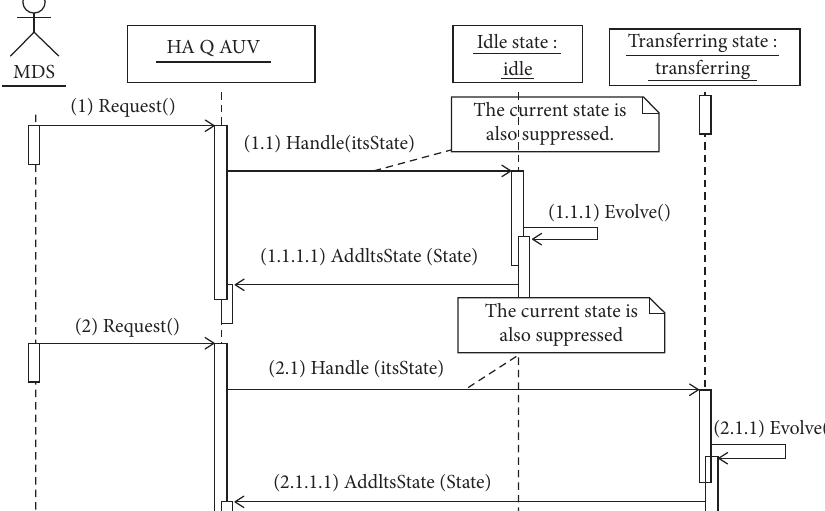
Figure 9: An example of instantiation and use of state pattern of HA for the M-AUV